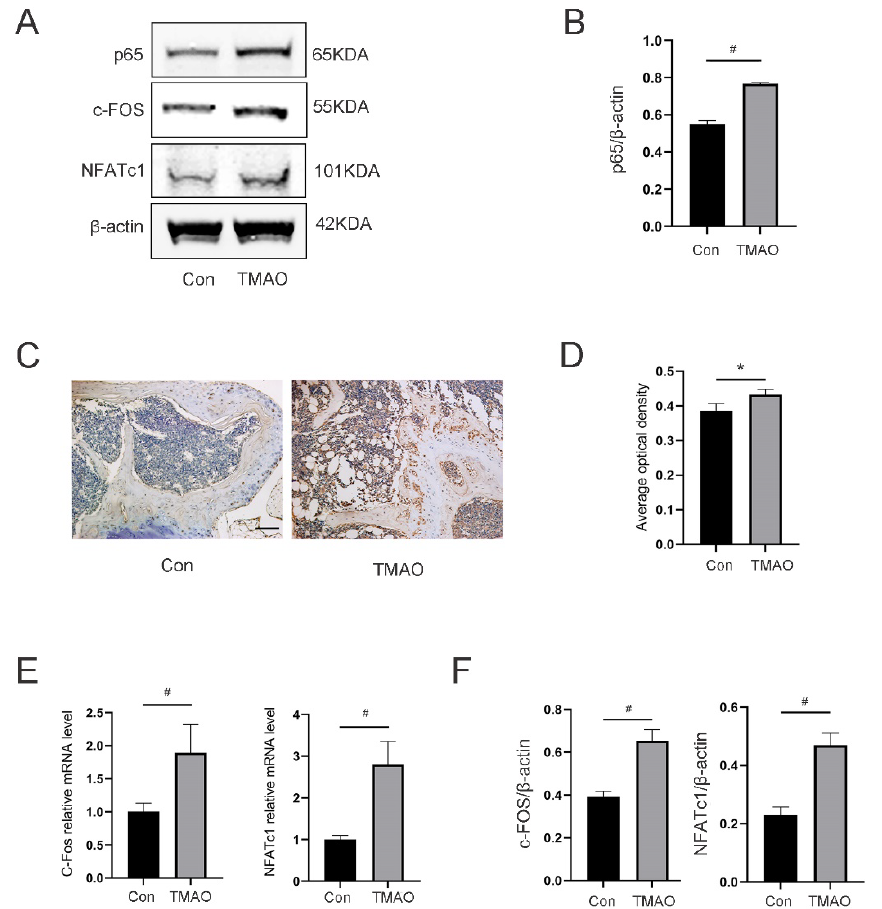
Figure 8. TMAO increased the expression of osteoclast genes and NF- κB signaling in mice. ( A ) Representative Western blot bands of NF- κB p65, c -Fos and NFATc1 relative to β -actin. ( B ) The expression of NF- κB p65 in the TMAO group was significantly increased compared to the control group ( n = 3 per group). ( C ) Representative femur section images of immunohistochemical staining of p65 from mice of control and TMAO groups. Scale = 5 μm. ( D ) TMAO significantly promoted average optical density (AOD) of p65. ( E ) TMAO significantly promoted C-Fos and NFATc1 gene expression in bone marrow examined by real-time PCR in vivo ( n = 3 per group). ( F ) TMAO significantly promoted C-Fos and NFATc1 protein expression in bone marrow examined by Western blot in vivo ( n = 3 per group). * p < 0.05, # p < 0.01.